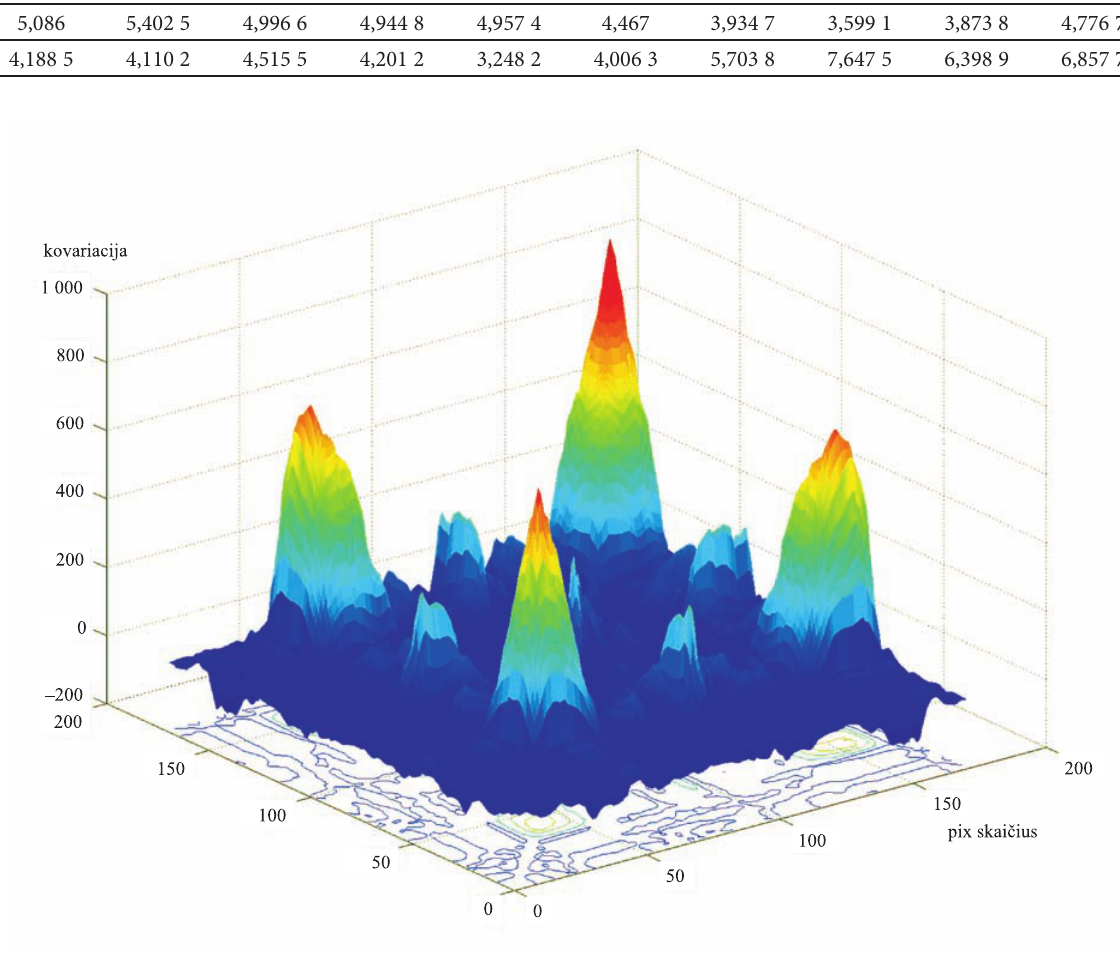
Fig. 3. Graphical view of the auto-covariance matrix of the digital view of the magnetic resonance of the damaged human brains